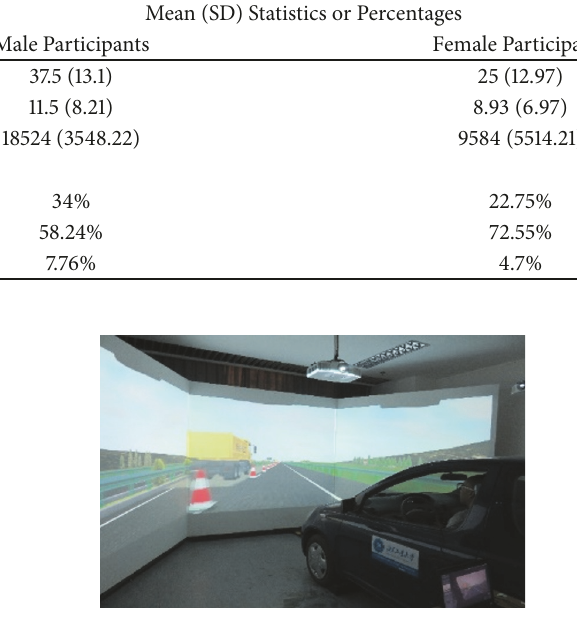
Figure 1: Fixed-base driving simulator at the Beijing University of